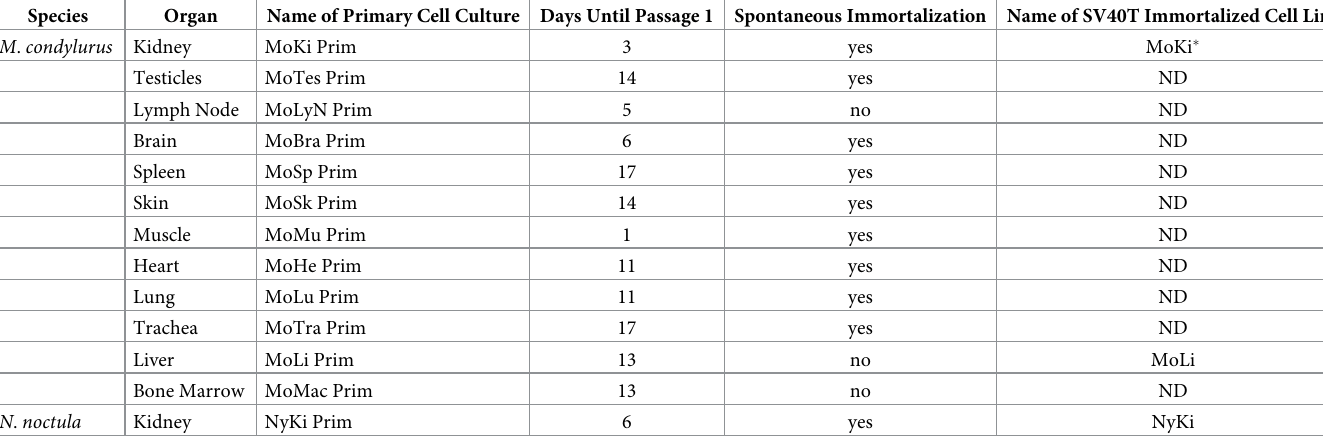
The first two letters indicate the species (Mo = Mops condylurus ; Ny = Nyctalus noctula ). The following two or three letters indicate the organ, from which the cell culture was derived from. SV40T immortalized cell lines have no further code. Prim = Primary cell cultures / not SV40T immortalized cell cultures. � = cloned; ND = not